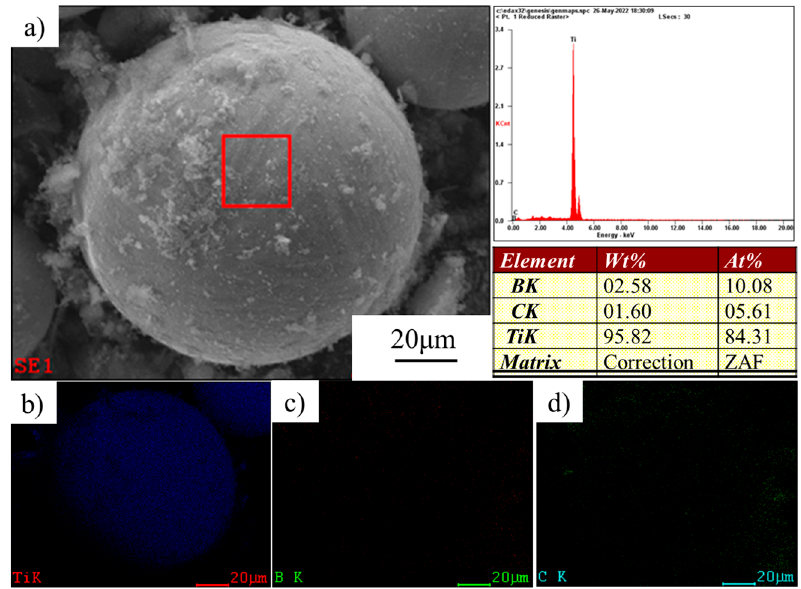
Figure 5. ( a ) EDS characterization of core-shell Ti-B 4 C structure; ( b – d ) surface scanning analysis of Ti, B and C elements, respectively.